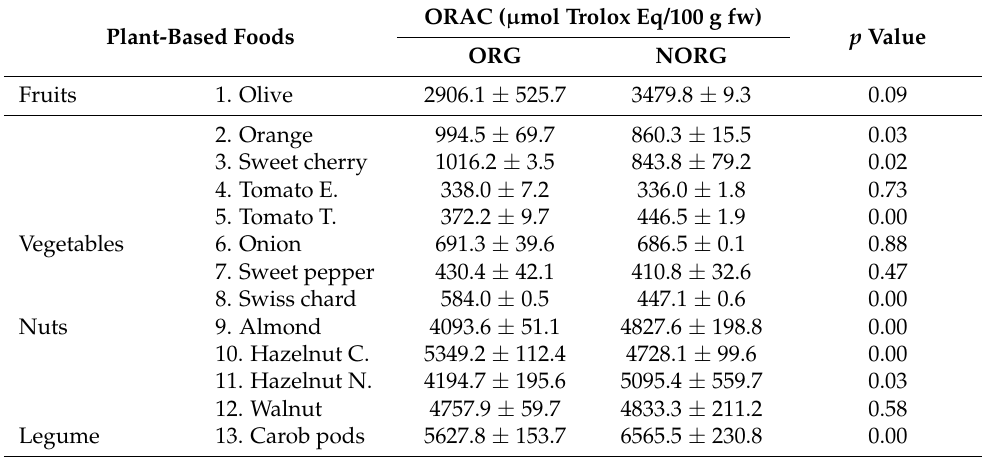
Figure 2. Distribution of variability in the phenolic compounds content of organic plant-based foods compared to the non-organic ones. Each point represents the % variability in PPC of the same plant-based food and cultivar, which is labeled with a number. That is, plus and minus signs refer to more or less abundance of a PPC from an organic sample with respect to non-organic sample as the baseline for comparison. Abbreviations: Cy3R, cyanidin-3- O -rutinoside; Eq, equivalent; GA, gallic acid; Hazelnut C, hazelnut cv. Castanyera; Hazelnut N, hazelnut cv. Negreta; NORG, non-organic farming; ORG, organic farming; PPC, phenolic compounds content; TAC, total anthocyanins content; TFaC, total flavan-3-ols content; TFoC, total flavonols content; Tomato E, tomato cv. Ekstasis; Tomato T, tomato cv. Tores; TPC, total phenolic content. Table 1. Antioxidant capacity of organic and non-organic plant-based